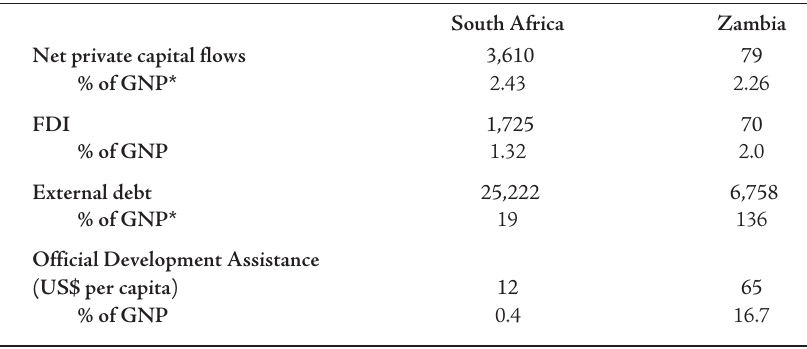
Table 6 – Aid and Financial Flows,